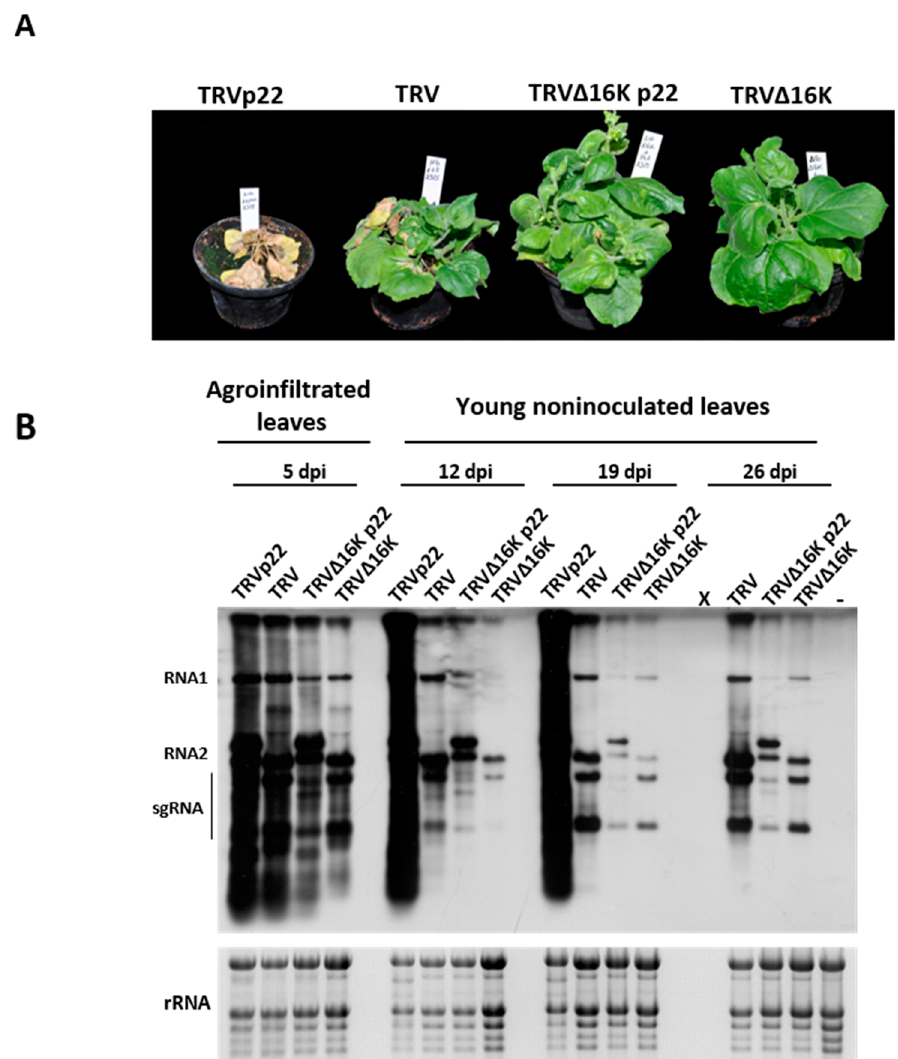
Figure 2. Analysis of Nicotiana benthamiana plants inoculated with Tobacco rattle virus (TRV) expressing Tomato chlorosis virus p22 (TRVp22), TRV, TRV ∆ 16Kp22, and TRV ∆ 16K. ( A ) Symptoms on N. benthamiana following inoculation with TRVp22, TRV, TRV ∆ 16Kp22, and TRV ∆ 16K at 19